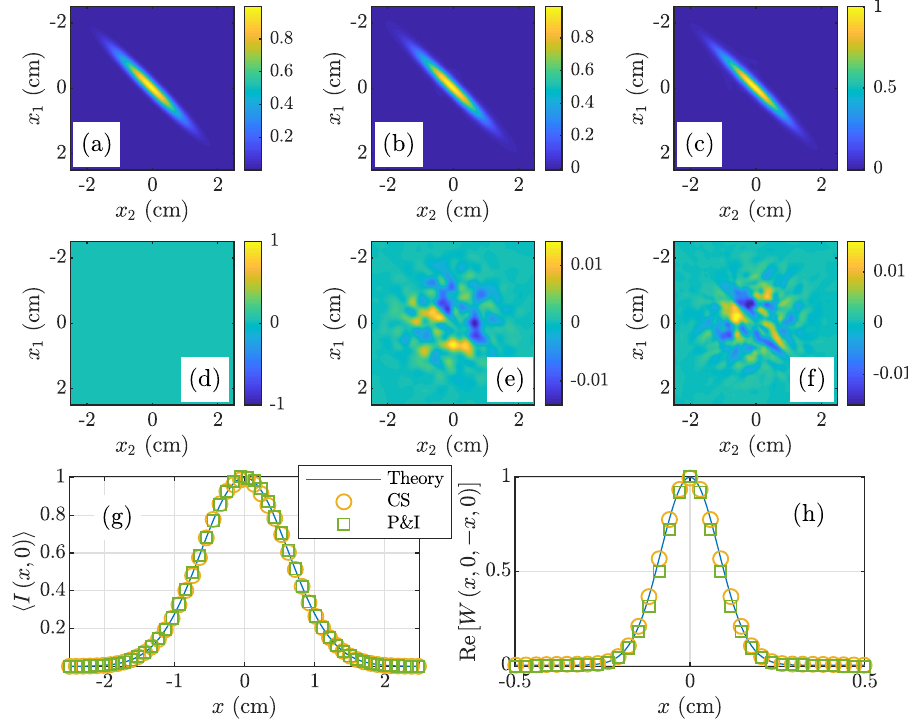
Figure 2. GSM beam cross-spectral density (CSD) function results—( a ) theory, ( b ) CS, and ( c ) P&I Re [ W ( x 1 ,0, x 2 ,0 )] ; ( d ) theory, ( e ) CS, and ( f ) P&I Im [ W ( x 1 ,0, x 2 ,0 )] ; ( g ) theory, CS, and P&I (cid:104) I ( x ,0 ) (cid:105) ; and ( h ) theory, CS, and P&I Re [ W ( x ,0, − x ,0 )] . The CS and P&I field expressions are given in Equations (A5) and (2), respectively. The theoretical CSD function is given in Equation